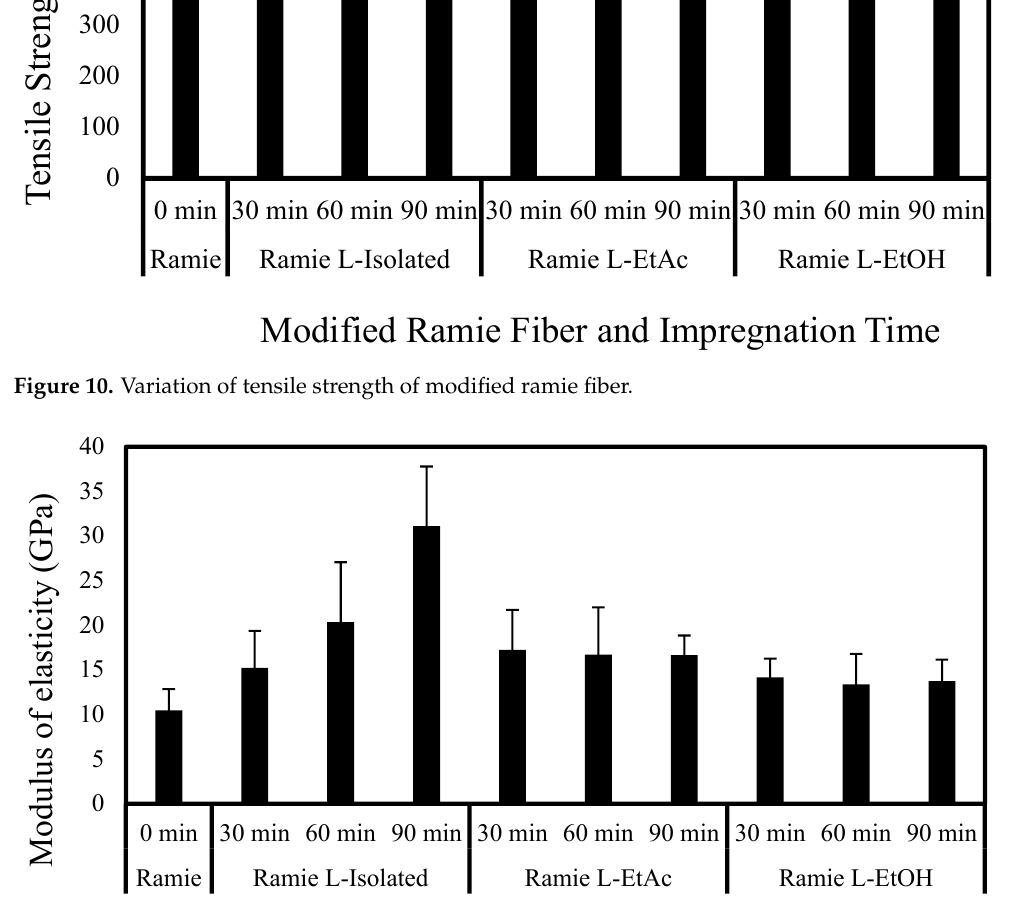
Figure 11. Variation of the modulus of elasticity (MOE) of modified ramie fiber. L-EtAc for 30 min has the highest tensile strength of 648.7 MPa. Meanwhile,